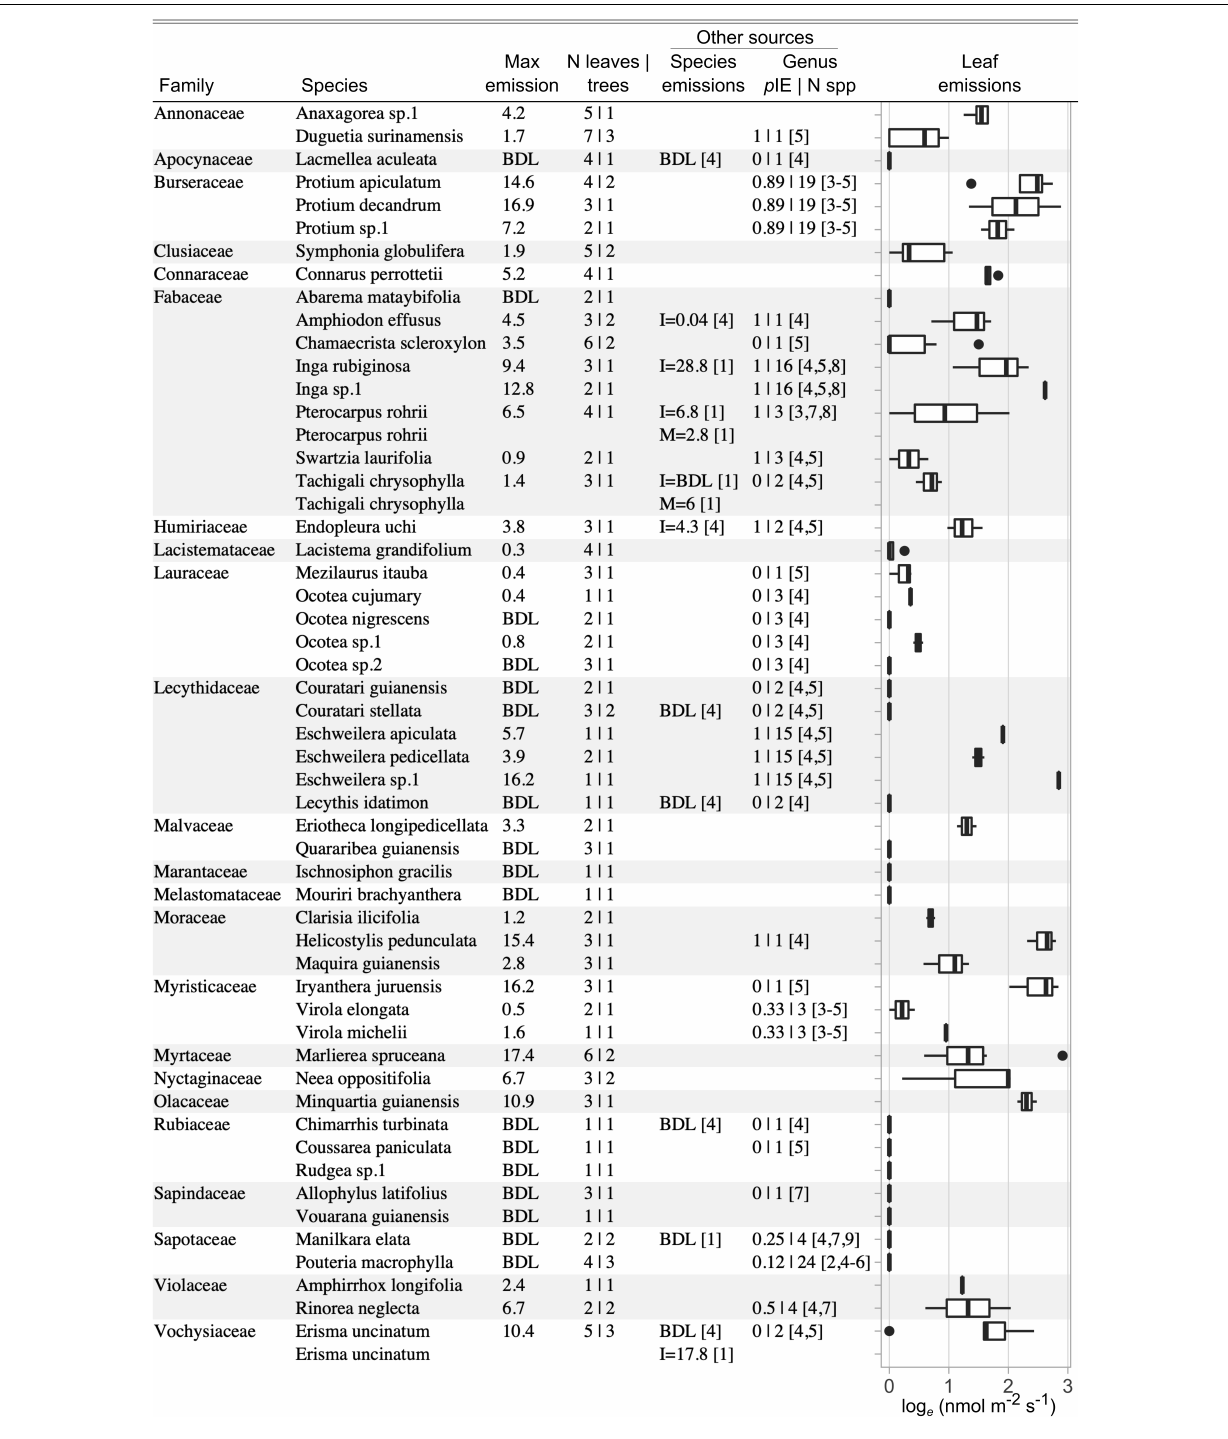
Frontiers in Forests and Global Change |